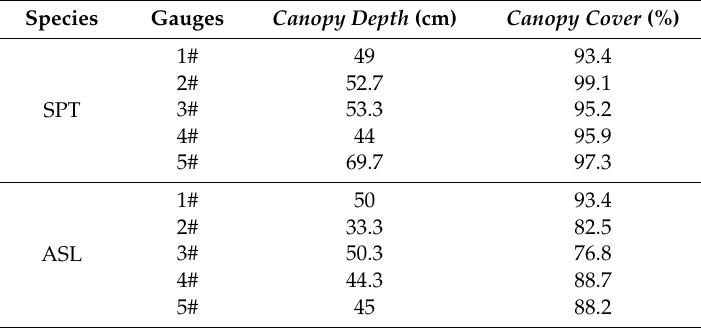
Table 3. Plant cover of throughfall-gauged plants.